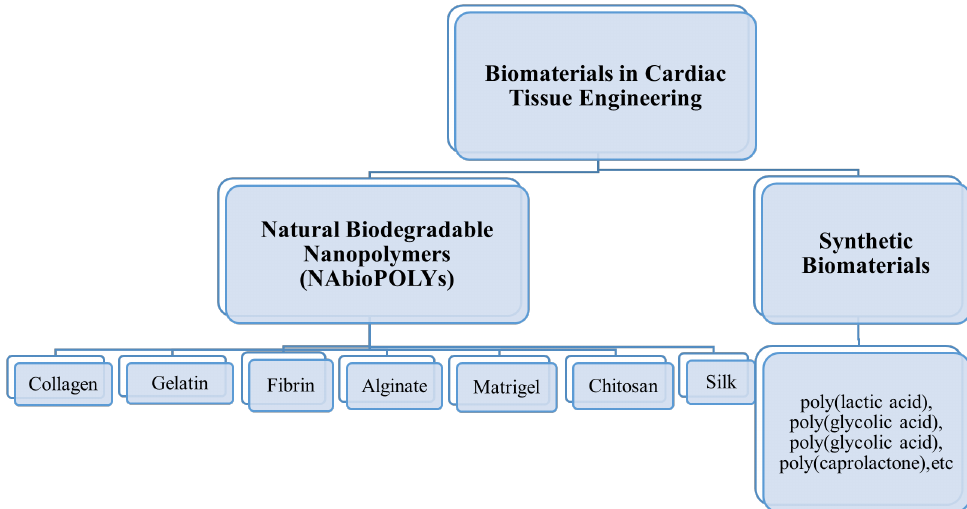
Figure 6. Types of biomaterials used in cardiac tissue